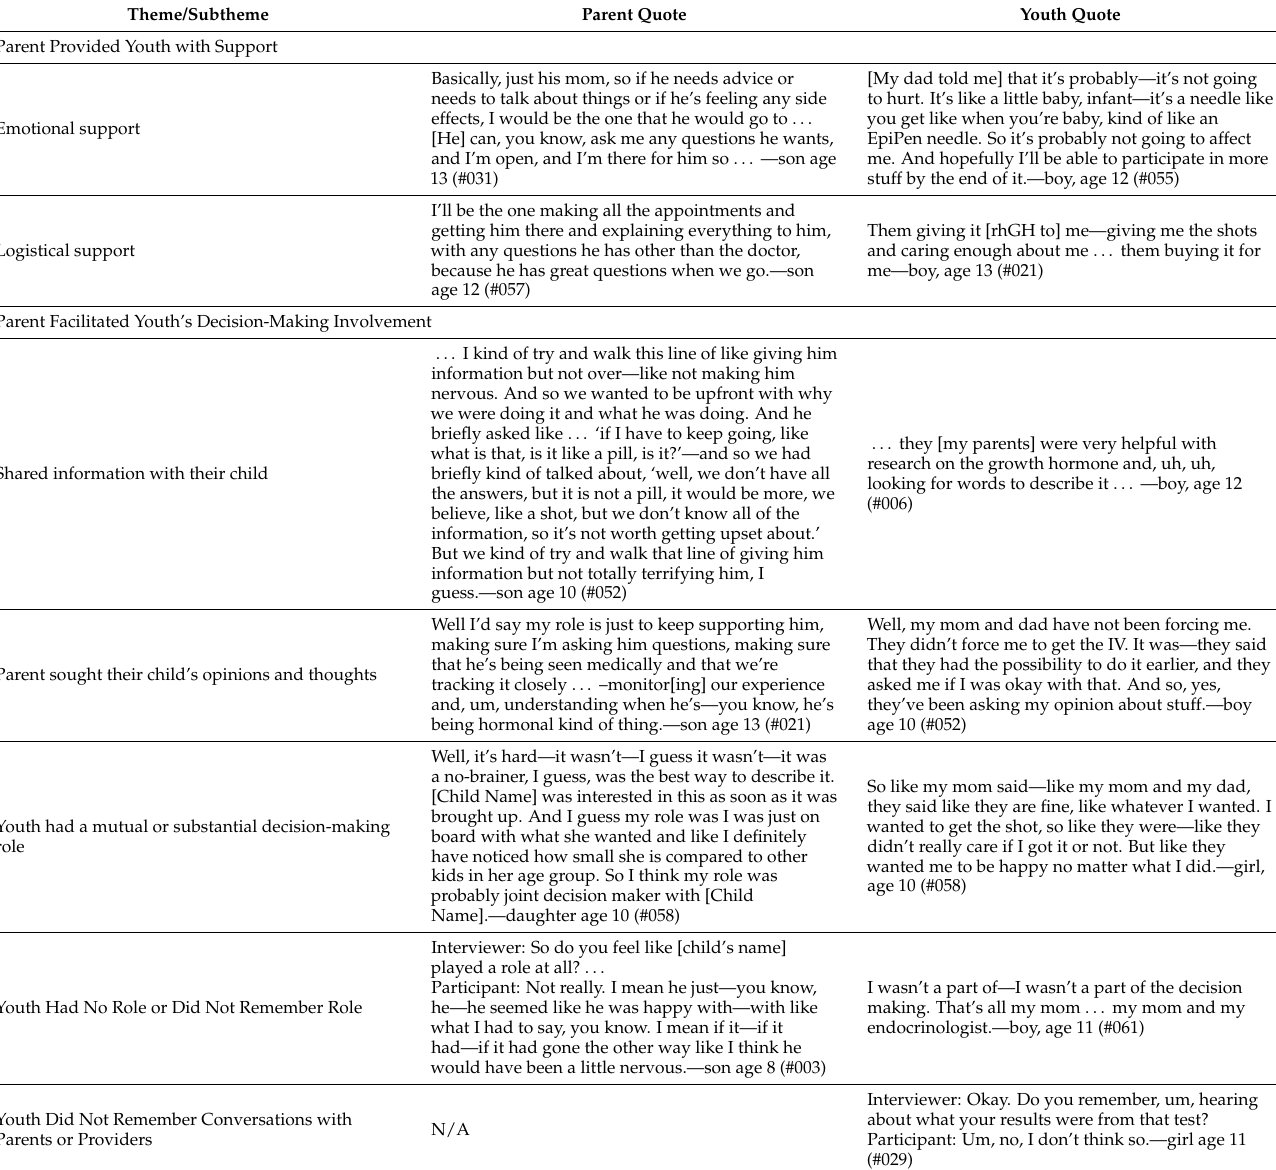
Table 2. Themes, Subthemes, and Representative Parent and Youth